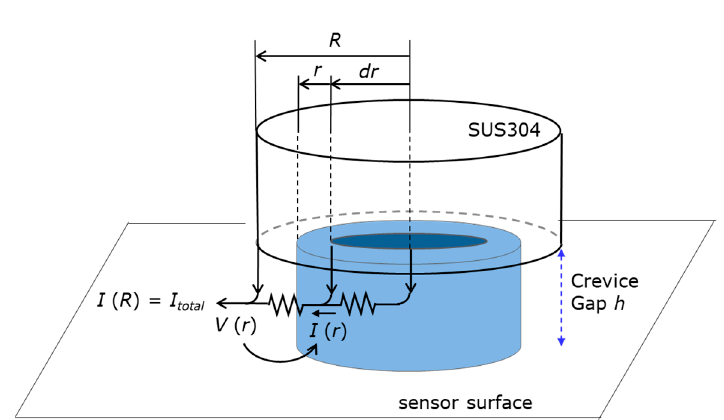
Figure 5. The model used for estimation of the crevice gap.